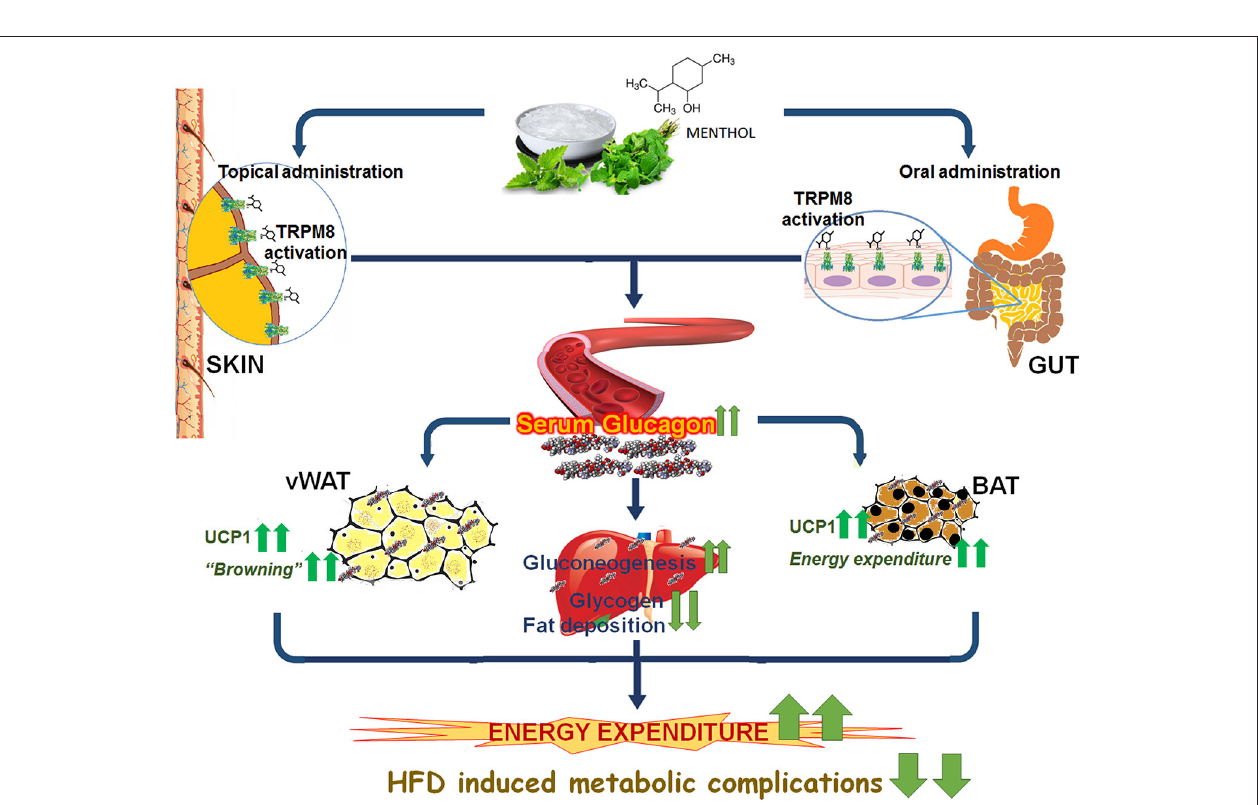
FIGURE 10 | Schematic diagram presenting glucagon mediated action of TRPM8 activators in HFD fed mice. Administration/application of TRPM8 activators via oral/topical routes increases serum glucagon level, which leads to the activation of multiple downstream catabolic processes i.e., glycogenolysis, gluconeogenesis, browning of WAT, and activation of energy expenditure markers in WAT and BAT. These effects pharmacologically mimic cold exposure-induced phenomenon and prevent HFD-associated insulin resistance, hepatic fat deposition, and weight gain.